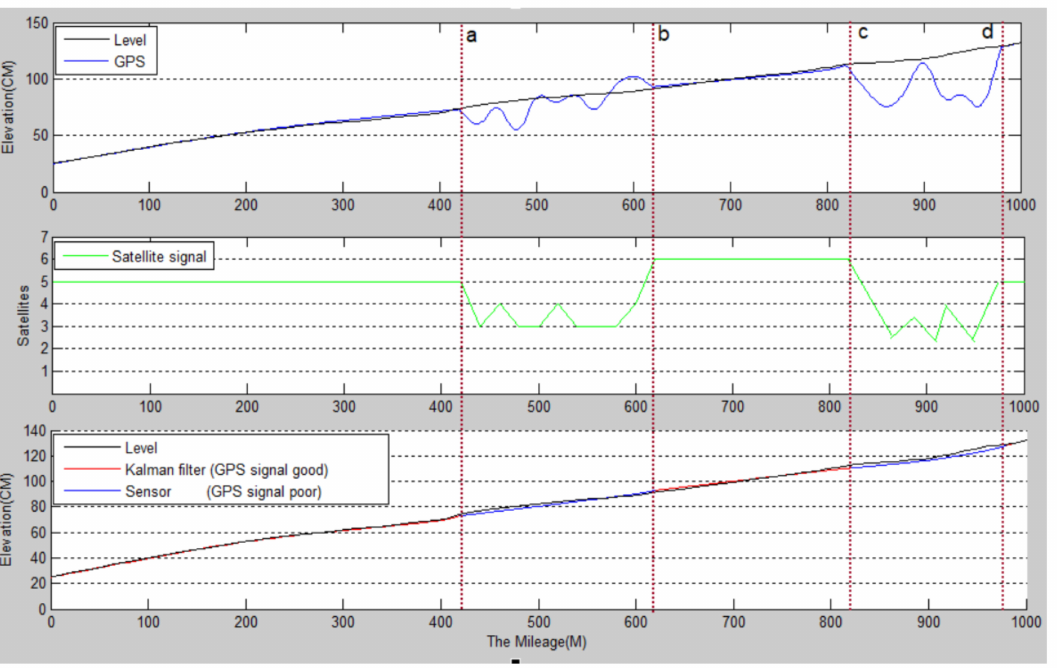
Figure 9. The undulating waveform of road surface obtained by the data fusion